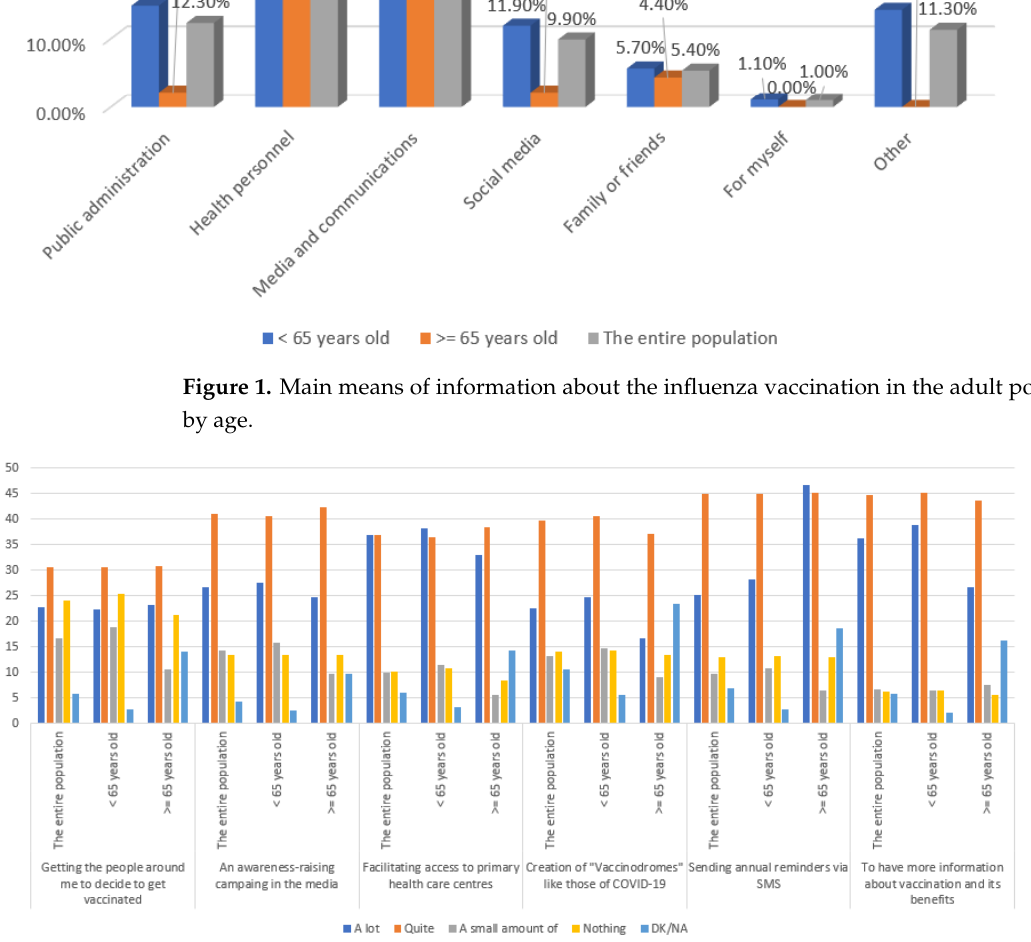
Figure 2. Measures to promote vaccination.